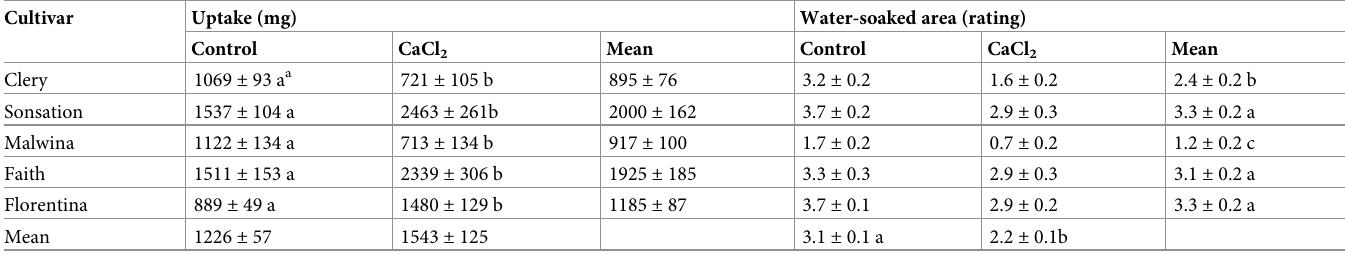
Table 2. Effect of CaCl 2 (10 mM) on water soaking of ripe strawberries of different cultivars. Fruit was incubated for 24 h. Cultivar